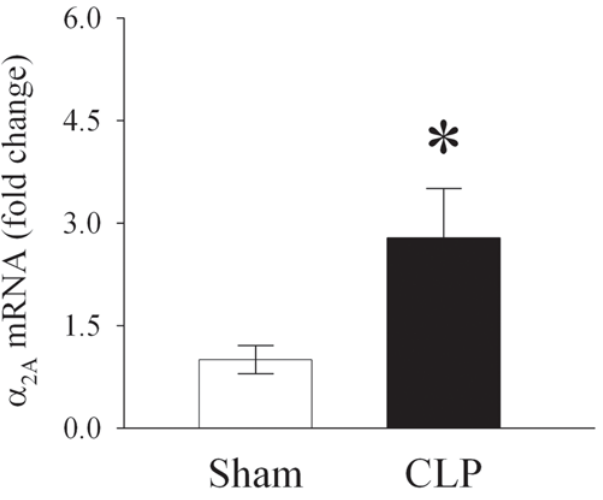
Figure 1. Upregulation of KC a 2A -AR expression in CLP-induced sepsis. Gene expression of a 2A -adrenergic receptor (AR) in Kupffer cells isolated from animals at 2 h after cecal ligation and puncture (CLP) or sham-operation. Relative expression of mRNA was calculated by the DD Ct -method, and results expressed as fold change with respect to the housekeeping gene GAPDH. Values (n=6/group) are presented as mean 6 SE and compared by Student’s t -test. *P , 0.05 vs. Sham.